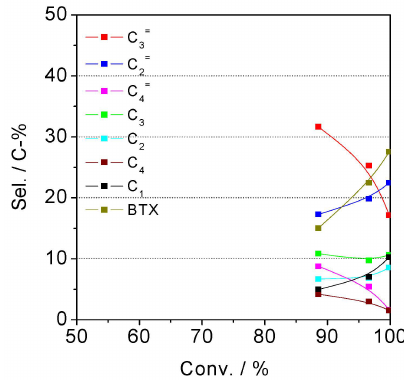
Figure 12. Change in products’ selectivities with n -hexane conversion on HB(12) catalysts. Reaction conditions: P n- hexane = 6 kPa; W / F n- hexane = 12.8–64 g h/mol; temperature 923 K, TOS = 15 min. Products abbreviations: see Figure